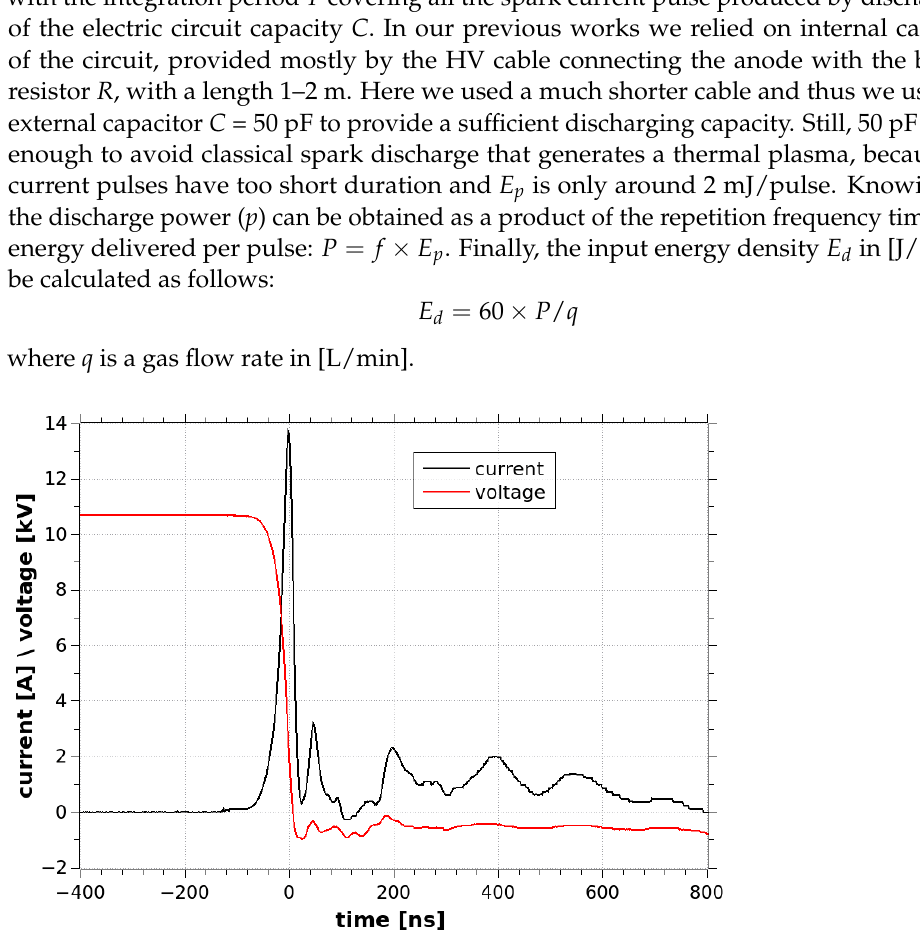
Figure 3. Typical current and voltage waveforms of the TS, short time scale showing the voltage drop and the current pulse associated with the gas breakdown.